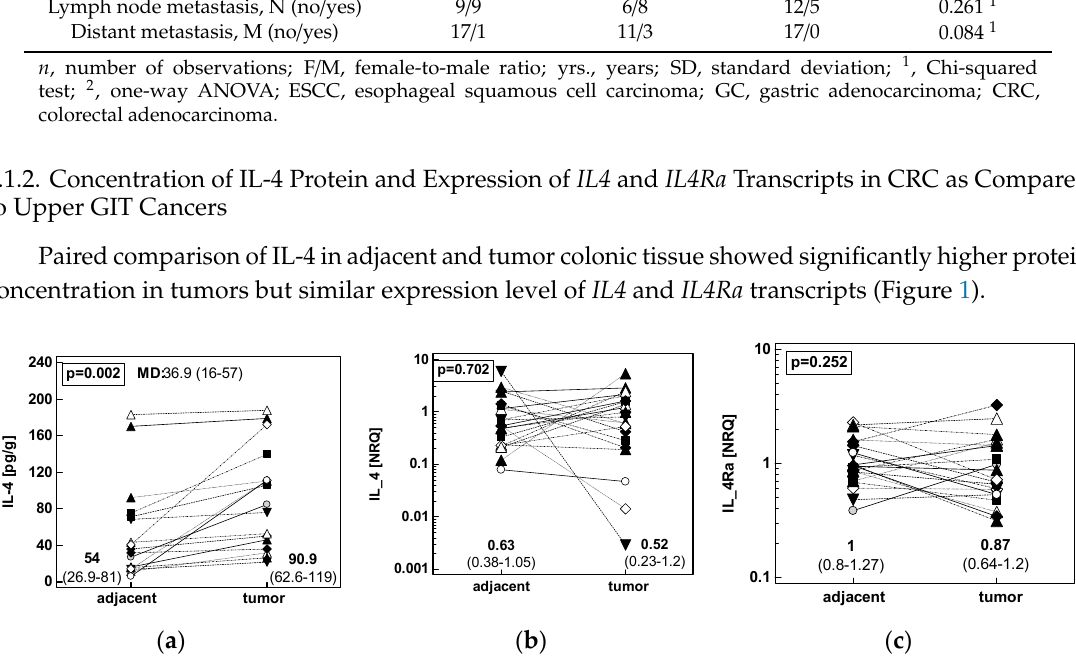
Table 2. Characteristics of study population for analysis of local interleukin expression at protein level.